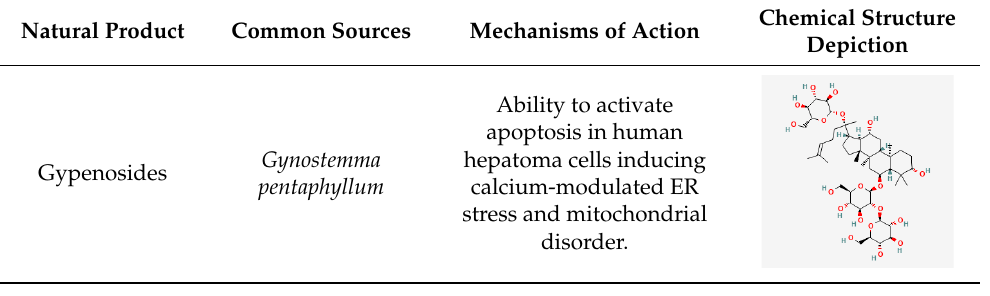
Chemical Structure Depiction